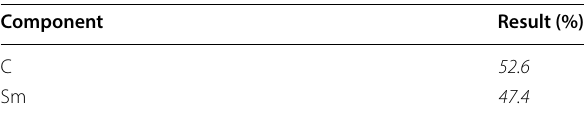
Table 1 Sm loading amount in the SC/Sm measured by XRF